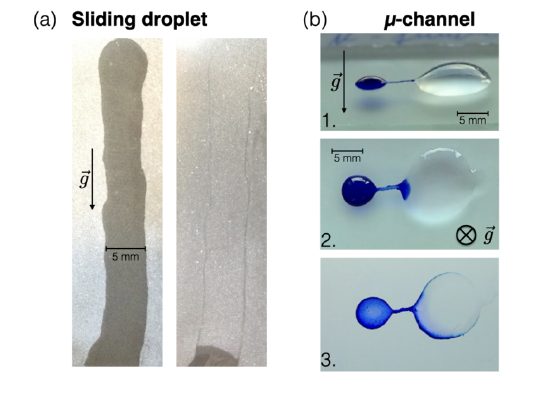
Figure 11: Water droplet – (a) After the passage of a droplet, a liquid film is released on the frosted glass (in the picture on the left). After evaporation we can observe a thin trace due to the accumulation of dust (picture on the right). (b) Due to the pinning of the contact line, a micro-channel can be drawn between two droplets (1). The liquid can then flow from the smallest to the biggest droplet (2). The flow rate changes during the evaporation process. Picture 3 shows the result after complete evaporation of the